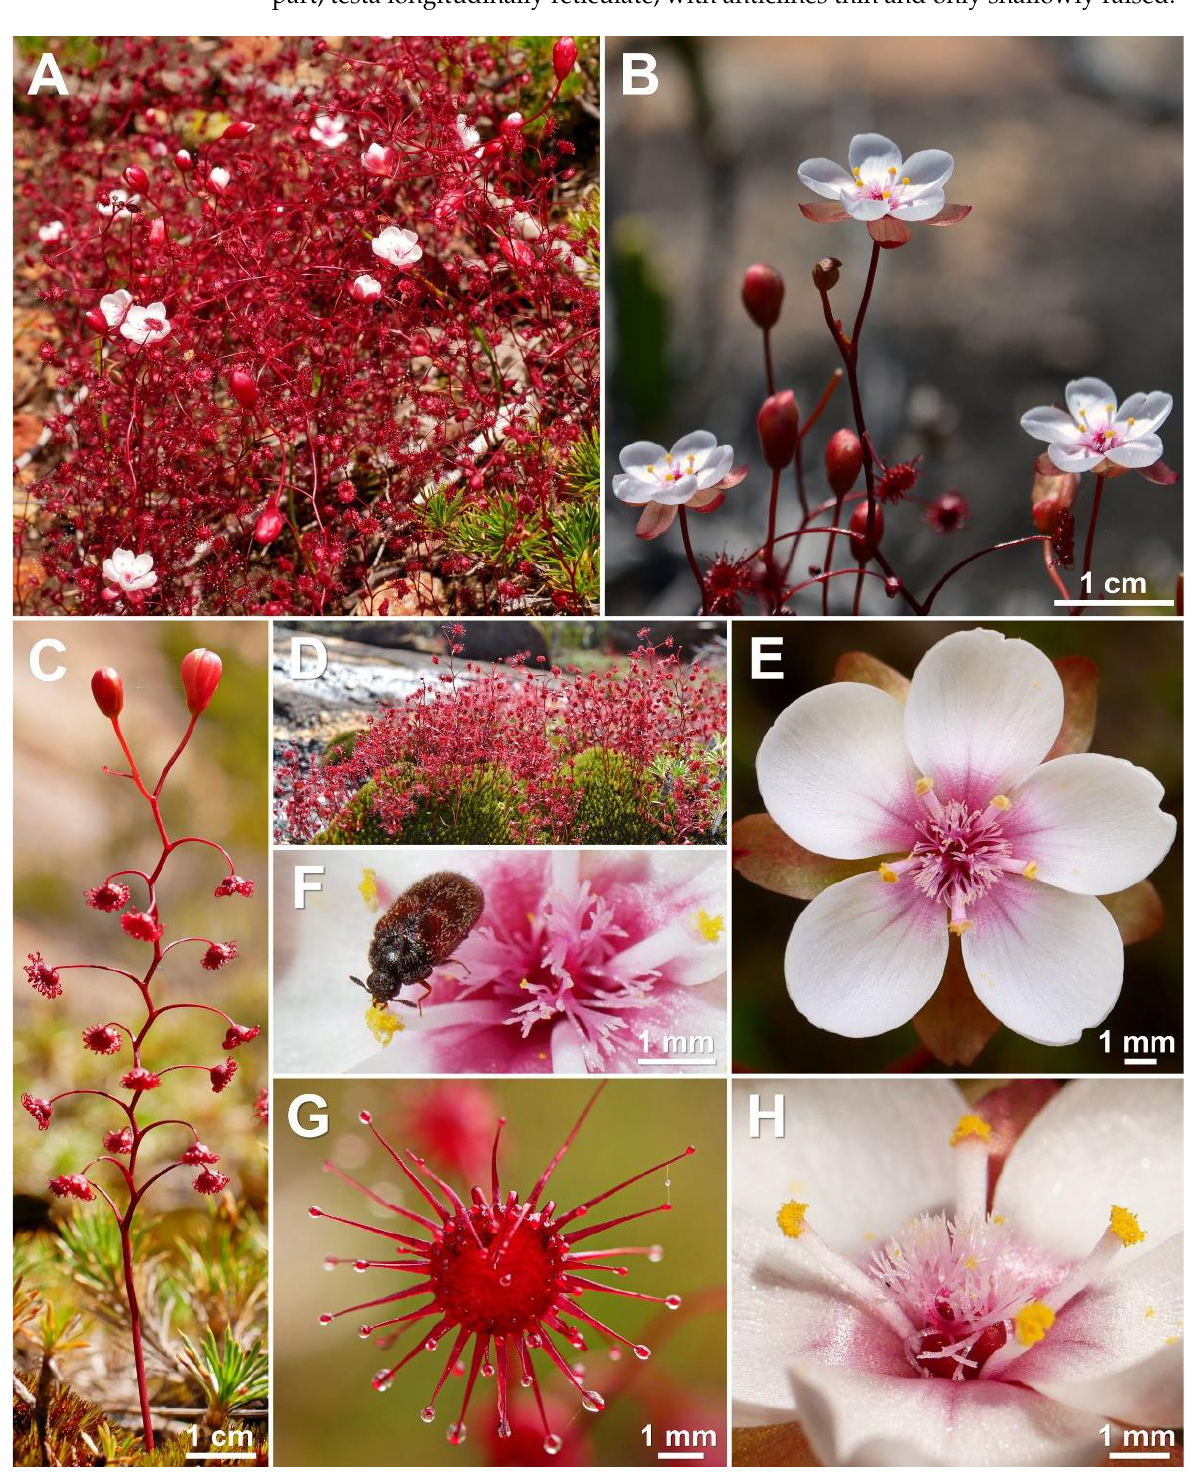
Figure 7. Drosera esperensis Lowrie. ( A – D ) habit; ( E ) flower in diffuse light; ( F ) flower with observed pollinator (a pollinivorous beetle of the family Dermestidae); ( G ) lamina; ( H ) stamens and styles (one stamen is missing). ( A , C , E – H ) from Cape Le Grand National Park, Western Australia, 19 September 2022; ( B , D ) from Cape Le Grand National Park, Western Australia, 16 September 2014. Images: T. Krueger.